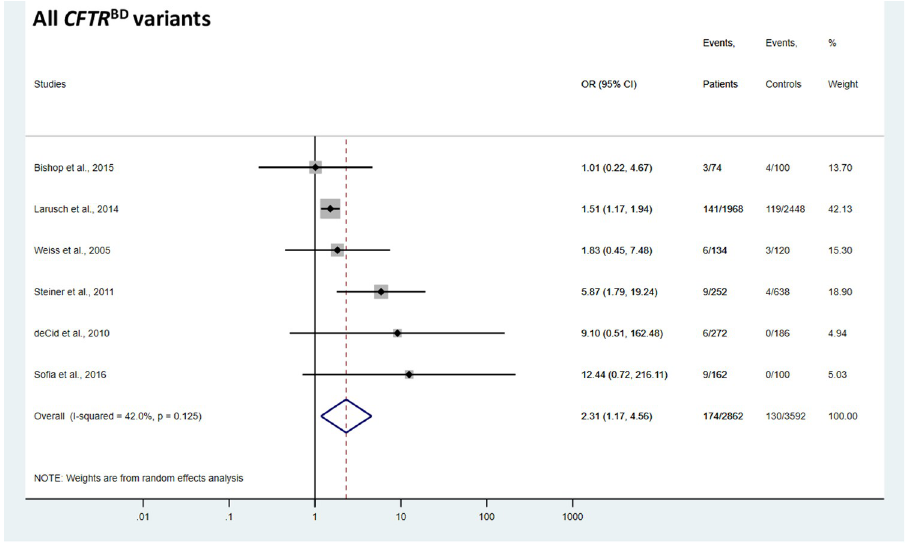
Fig 2. Forest plot showing cumulative odds ratios for chronic pancreatitis risk in carriers of CFTR BD variants. OR, odds ratio; CI, confidence interval.